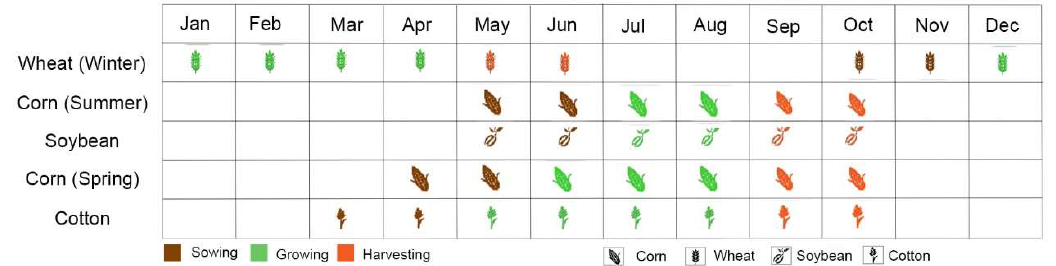
Figure 2. Crop calendar for the dominant crops in Hebei Province.